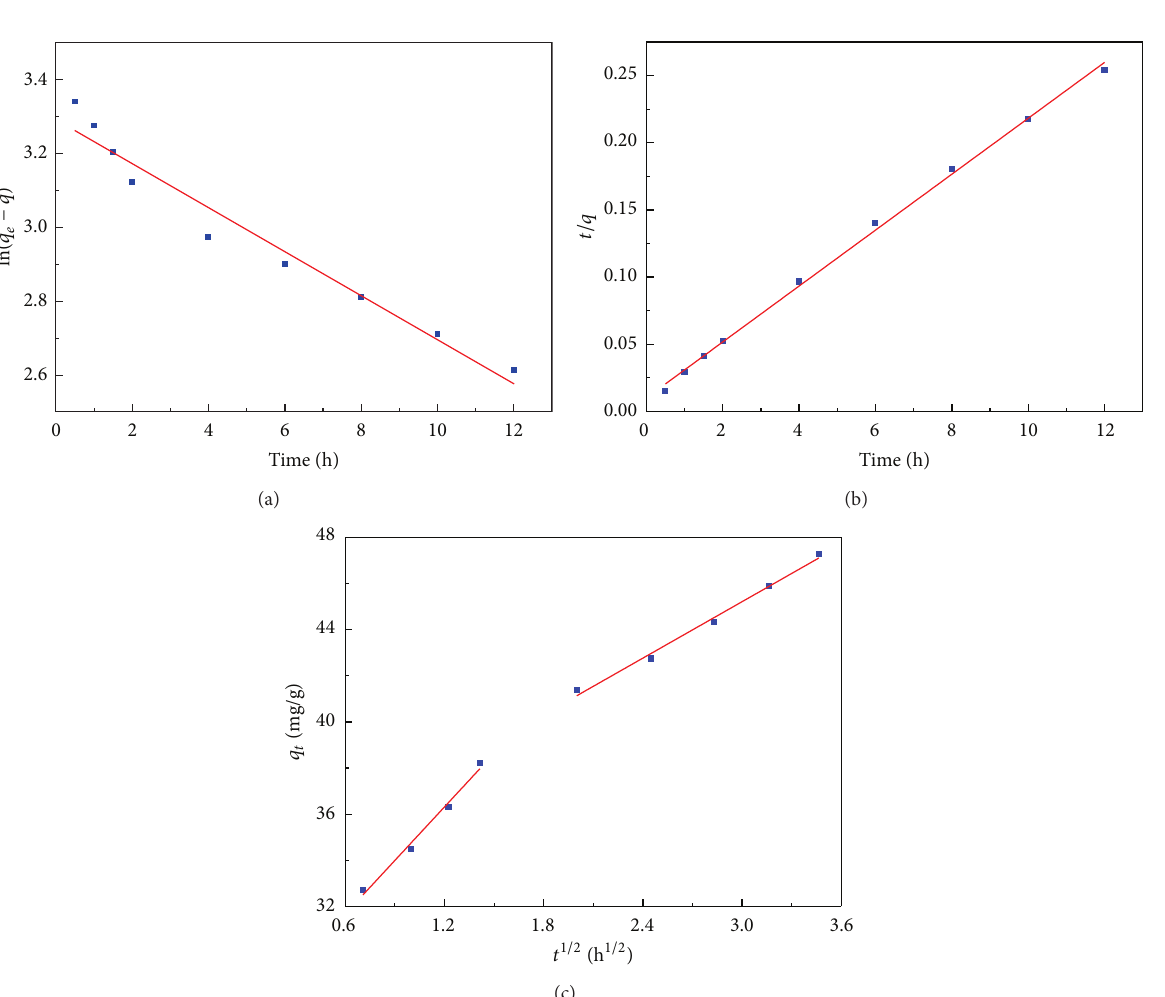
Figure 6: (a) Pseudo-first-order model fit for the adsorption of Cr(VI) by NH 2 -MCM-41. (b) Pseudo-second-order model fit for the adsorption of Cr(VI) by NH 2 -MCM-41. (c) Intraparticle diffusion model fit for the adsorption of Cr(VI) by NH 2